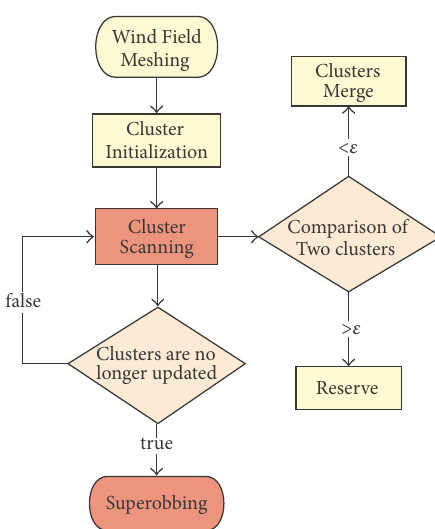
Figure 1: Flow of the superobbing with feature box algorithm. 𝜀 is the proportional